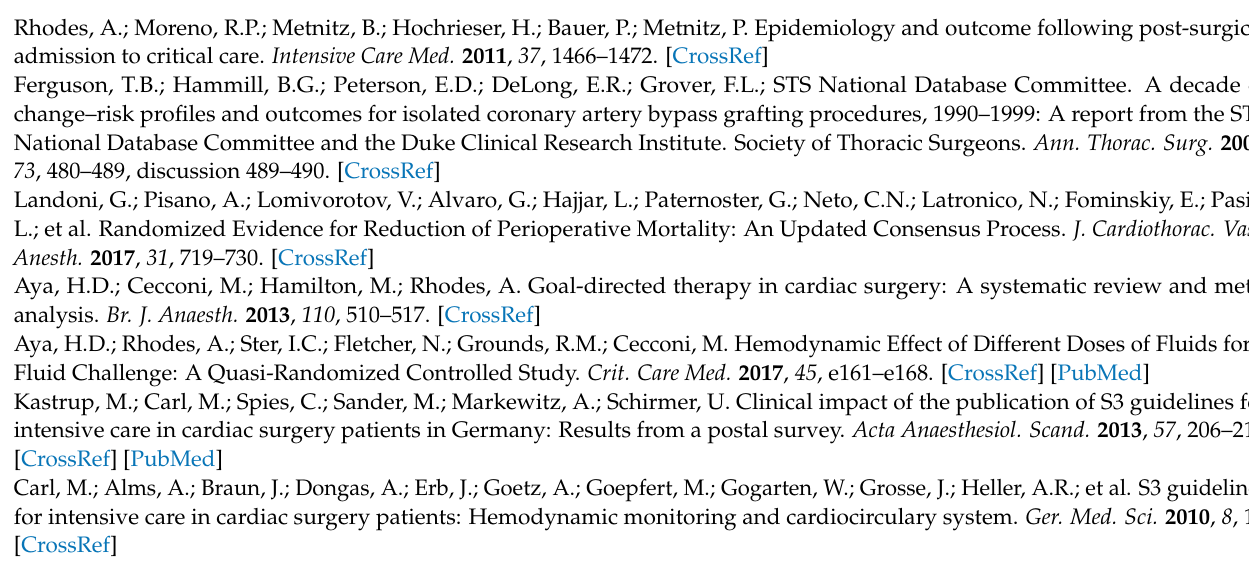
Figure S3: survival probability over time, unmatched cohort, Figure S4: all postoperative CVP values > − 10 mmHg and < 35 mmHg up to 180 days after cardiac surgery, Figure S5: histogram of calculated median initial CVP values, Figure S6: box plot of miCVP values and intubation status at time of measurement, Figure S7: result of cutpointr analysis of optimum cutoff value of miCVP to predict mortality; AUC is 0.63. Table S1: Morphometry of unmatched cohort. Table S2: Outcome parameters of unmatched